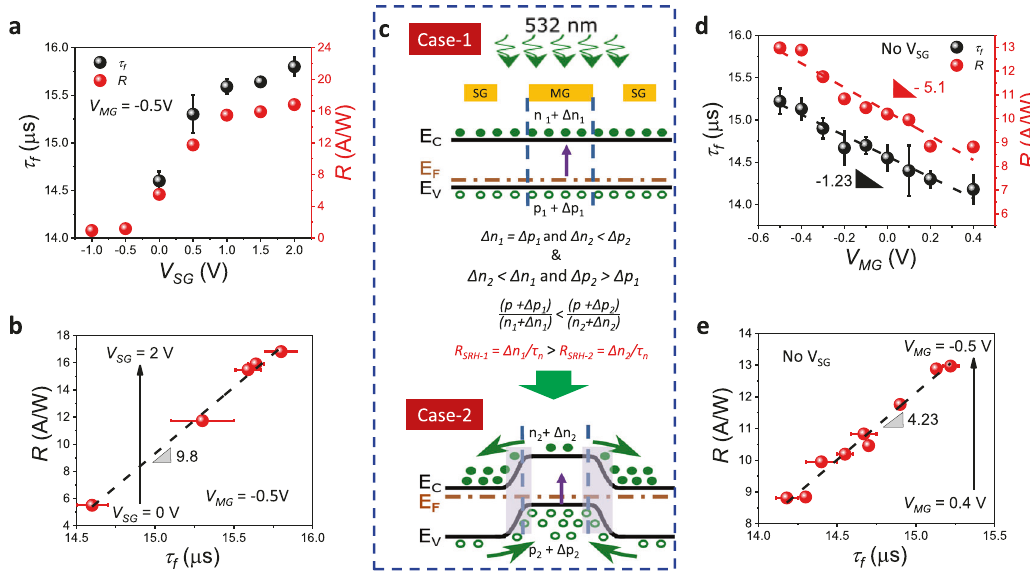
Fig. 4 Temporal photoresponse of the WSe 2 phototransistor. For fi xed V MG = − 0.5 V and varying V SG ( a ) Responsivity ( R ) and fall time ( τ f ) data. b R vs τ f trade-off indicating a slope of 9.8 A/Ws. c Schematic band diagrams depicting recombination rate (R SRH ) dependence on carrier concentrations for (1) p S – p M – p S ( V SG = V MG = − 0.5 V) and (2) n S – p M – n S ( V SG = 2 V, V MG = − 0.5 V) con fi gurations. More charge (e-h) separation under n S -p M -n S con fi guration leads to slower recombination and correspondingly higher lifetime, gain, R, and τ f . For varying V MG and No-V SG . d R and τ f data. e R vs τ f trade-off indicating a slope of 4.2